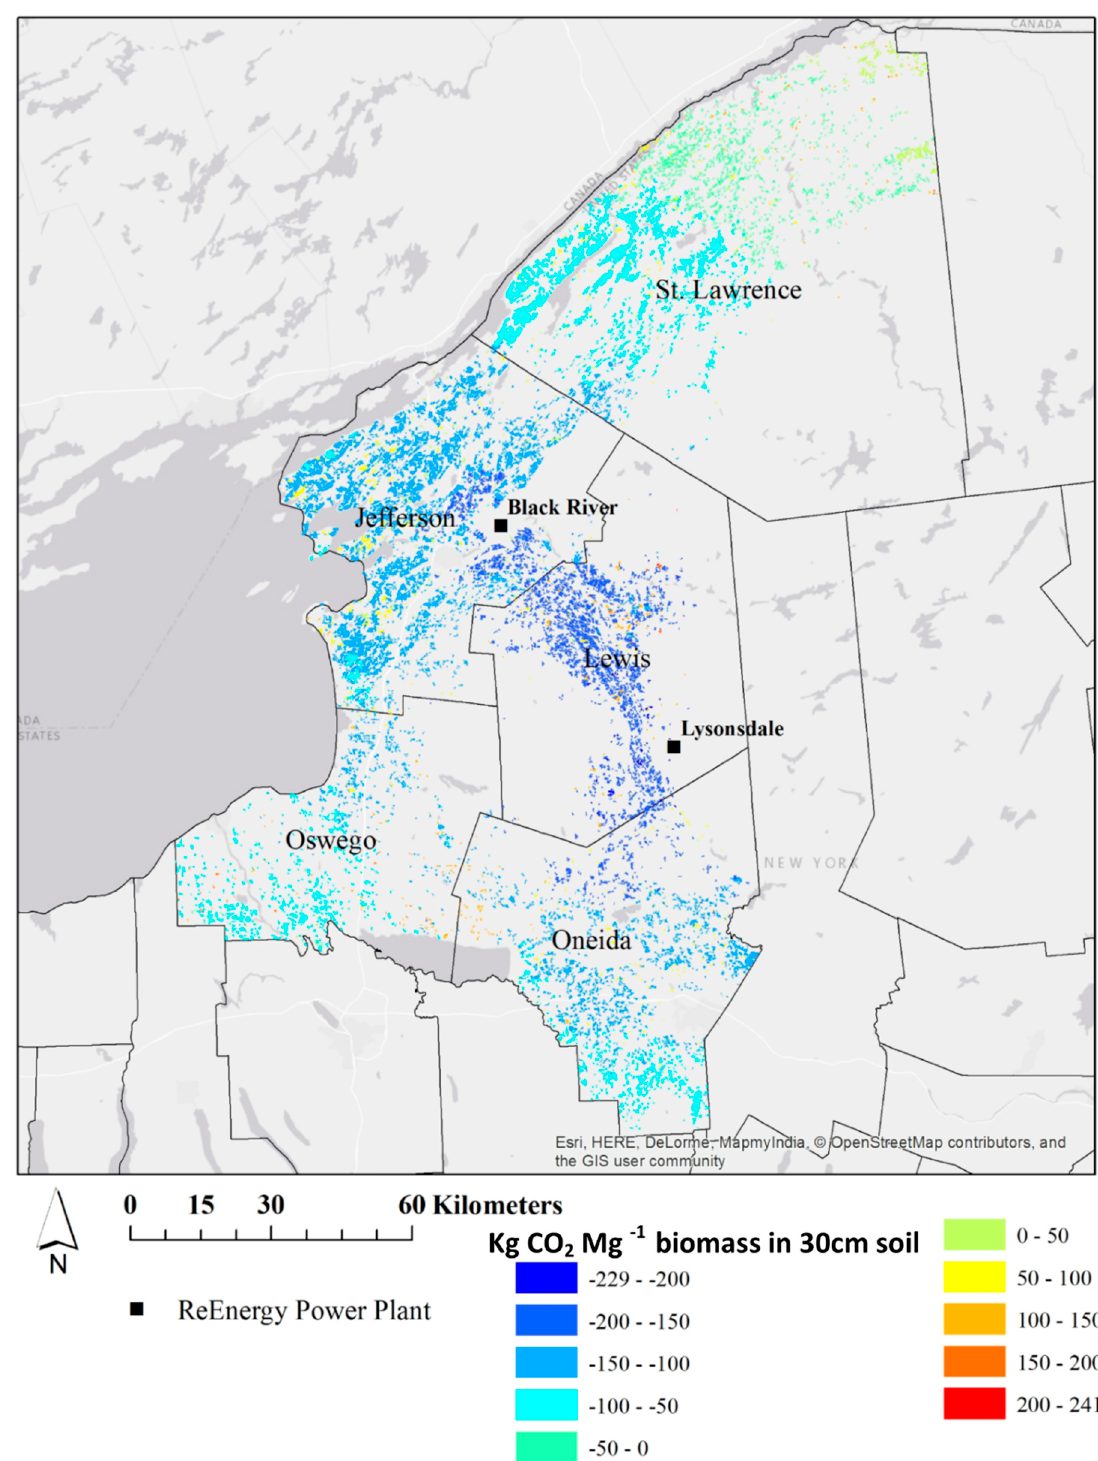
Figure 7. Life cycle willow GHG emissions measured in kg CO 2eq of producing 1 Mg dry biomass with SOC changes modeled for a 30 cm depth in suitable parcels in five counties. The high levels of CO 2 sequestration (in blue) occur mostly near the end use facilities (Black River and Lyonsdale).